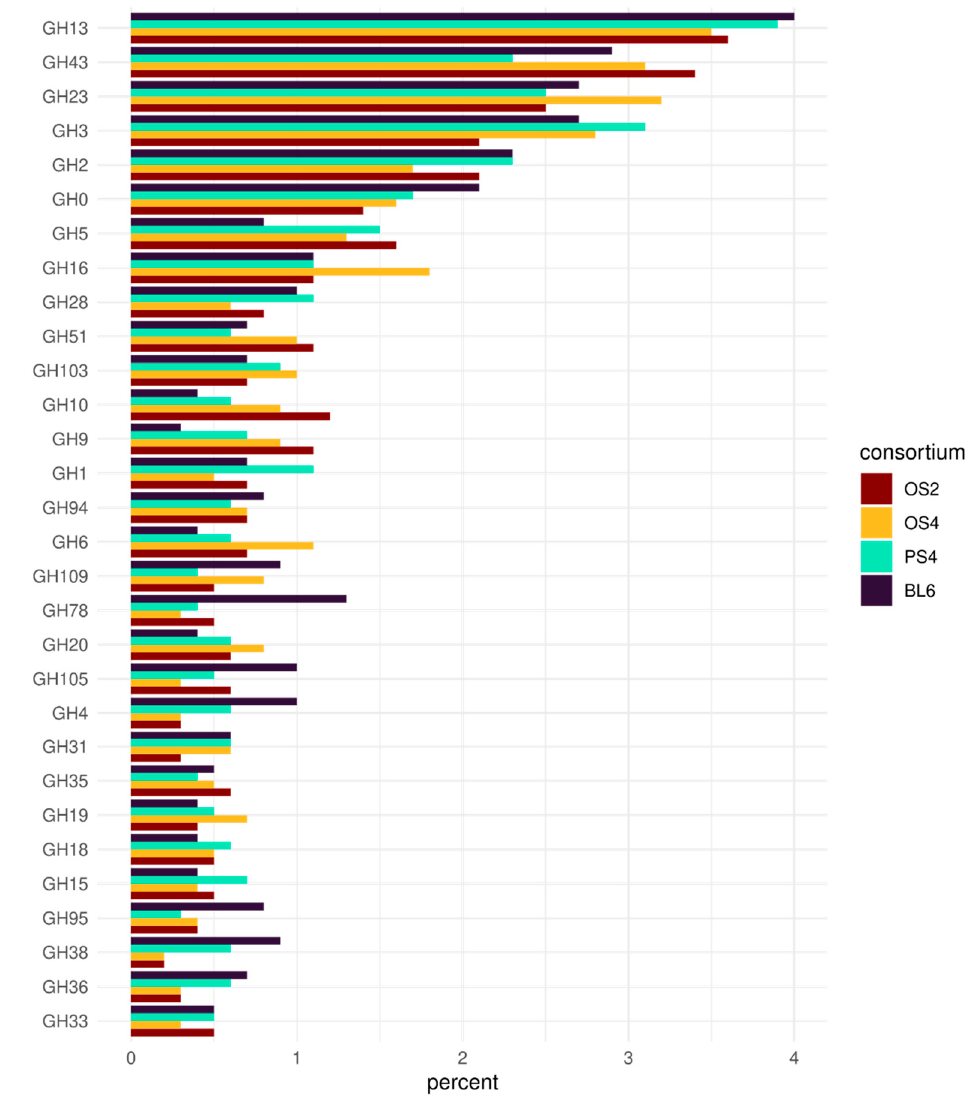
Figure 6. GH families in the four cellulolytic consortia (OS2, OS4, PS4,